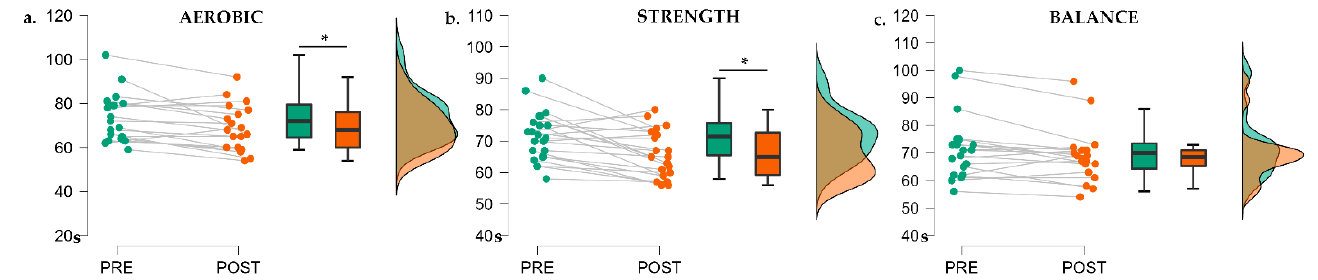
Figure 2. The raincloud plots for the different exercise sessions in the Color Condition. ( a ) Aerobic session. ( b ) Strength session. ( c ) Balance session. Time is measured in seconds ( Y -axis). * <0.05 in the post hoc analysis.